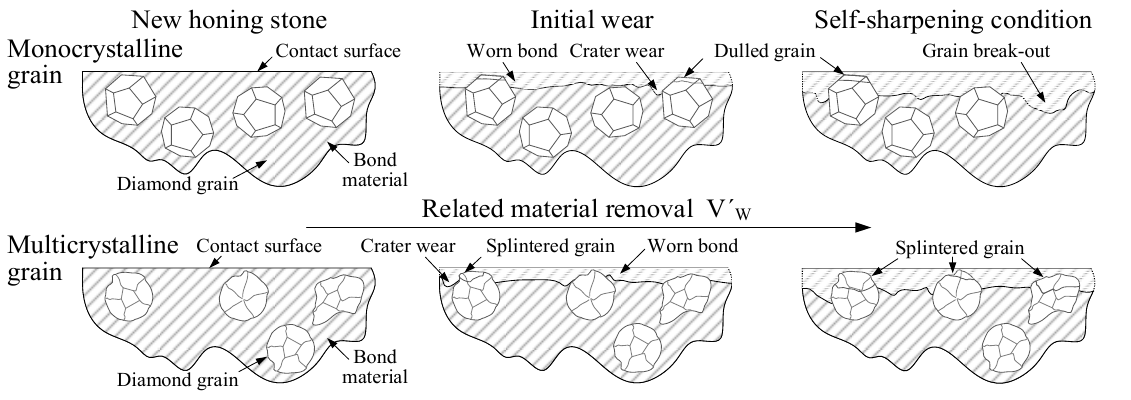
Figure 2. Schematic of honing stone wear for monocrystalline and multicrystalline diamond grains. The bond represents the main volume component within the cu tt ing layer of a honing stone and has the function of holding the cu tt ing grains in place until the cu tt ing perfor- mance is insu ffi cient by dulling. Afterwards, the dulled grains are supposed to disconnect form the bond in order to obtain subsequent sharp grains in operation.